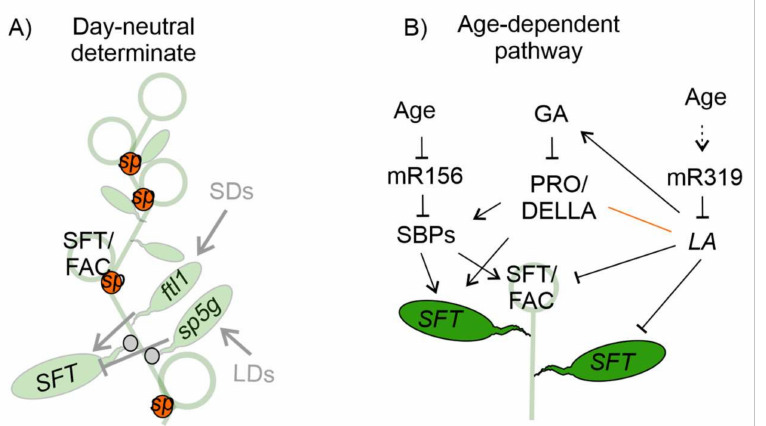
Figure 2. Tomato growth habits and regulation of flowering. ( A ) Day-neutral determinate cultivars bear non-functional alleles of sp , sp5g and ftl1 ; the sp mutation changes the growth pattern from indeterminate to determinate by abolishing the meristem-maintaining function of sp in SYMs. Mu- tations in sp5g and ftl1 render the plant nearly insensitive to photoperiodic cues. ( B ) Flowering in modern-day tomato cultivars is promoted by an age-dependent pathway that consists of a complex network that culminates in the regulation of the GA concentration [25]. SAMs are marked by open green circles, sympodial meristems by orange circles and axillary meristems by gray circles. Promo- tion is represented by arrows and repression by block arrows. SDs = short days; LDs = long days; SFT = single flower truss; FAC = florigen-activating complex; SBPs = squamosa protein binding-like; PRO/DELLA =